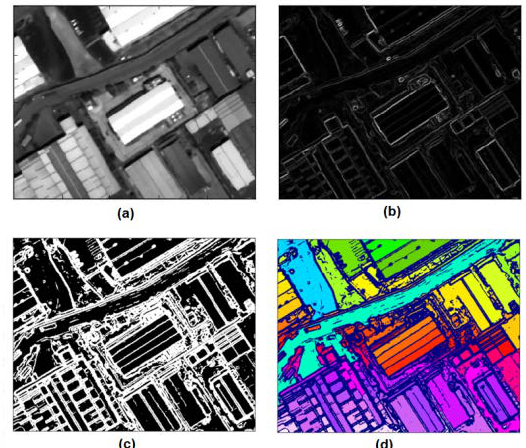
Figure 2: (a) Original panchromatic image; (b) Sobel gradient in horizontal and vertical direction; (c) Sobel lines (d) Original segment.